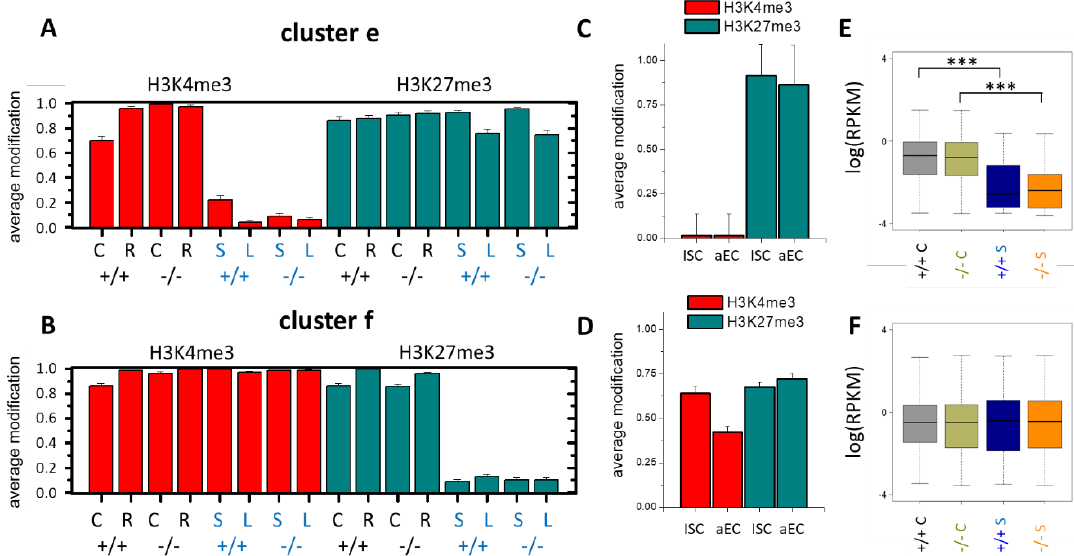
Figure 4. Epigenetic changes in the bivalent genes of clusters e and f : ( A ) Cluster e comprises 342 genes in state (11) in all the tissue samples that lose H3K4me3 in all the organoid samples (01). ( B ) Cluster f comprises 147 genes in state (11) in all the tissue samples that lose H3K27me3 in all the organoid samples (10). ( C , D ) Modification states in isolated ISCs and aECs based on the published data [27]. ( C ) Close to 100% of cluster e genes show the same modification state as in the organoids. ( D ) In contrast, about 60% of cluster f genes show the modification state seen in the tissue samples. ( E , F ) Box plots of the RNA-seq data of all spot genes in the 3 tissue and 3 short-term organoid samples. ( E ) Cluster e genes that lose H3K4me3 are, as expected, transcriptionally repressed. ( F ) The transcription of cluster f genes is unchanged; *** p -value < 0.001 ( t -test).